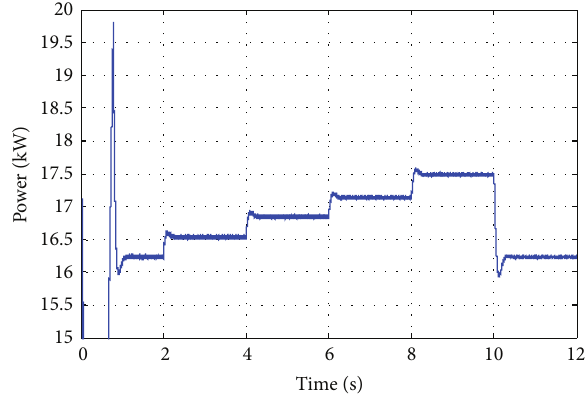
Figure 11: Evolution of Li-ion battery power in different climatic conditions.